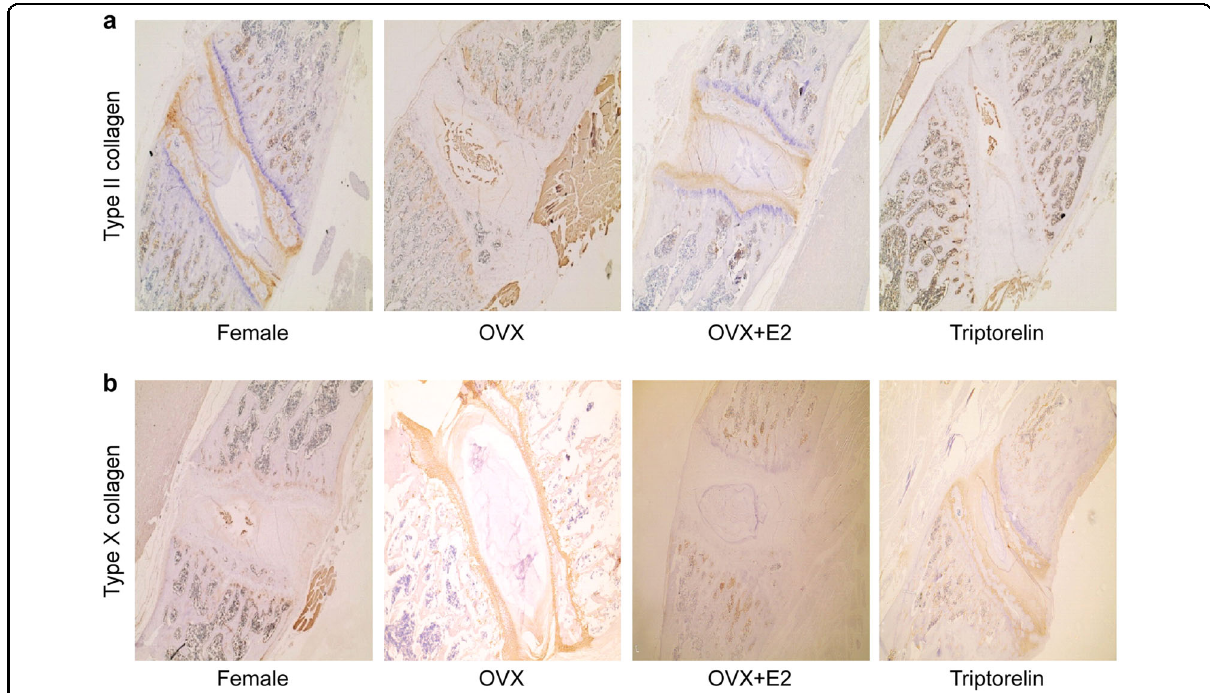
Fig. 4 Immunostaining for Col II and Col X in the vertebral growth plate cartilage from the four groups. a Cytoplasmic staining of Col II in the photographs showed lower Col II expression in the OVX and Triptorelin groups than in the female and OVX + E2 groups. b Cytoplasmic staining of Col X in the photographs revealed increased expression of Col X in the OVX and Triptorelin groups than in the female and OVX + E2